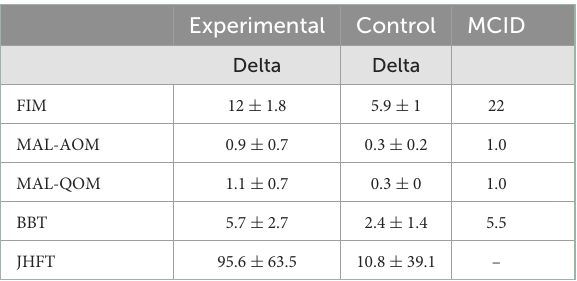
TABLE 3 Delta and minimal clinically important